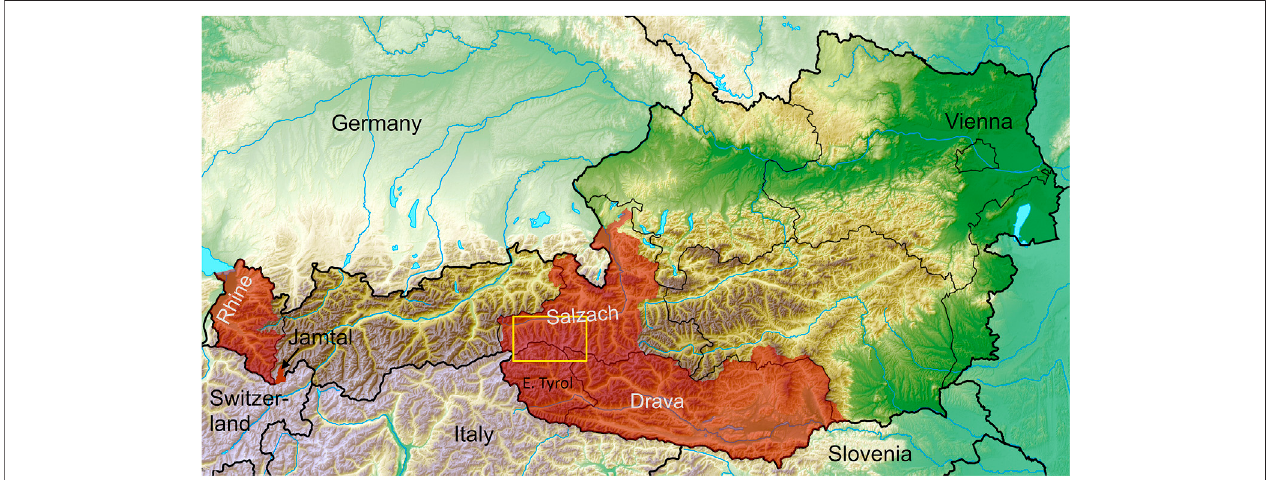
FIGURE 1 | Study areas (red) in the Austrian Alps including the catchments of the rivers Rhine, Salzach and Drava. The “ Jamtal ” valley in the province Tyrol was analyzed in detail to validate the historical land cover reconstruction (yellow rectangle: see detail in Figure 3 ; basemap: Wikimedia Commons, Tschubby 2018).